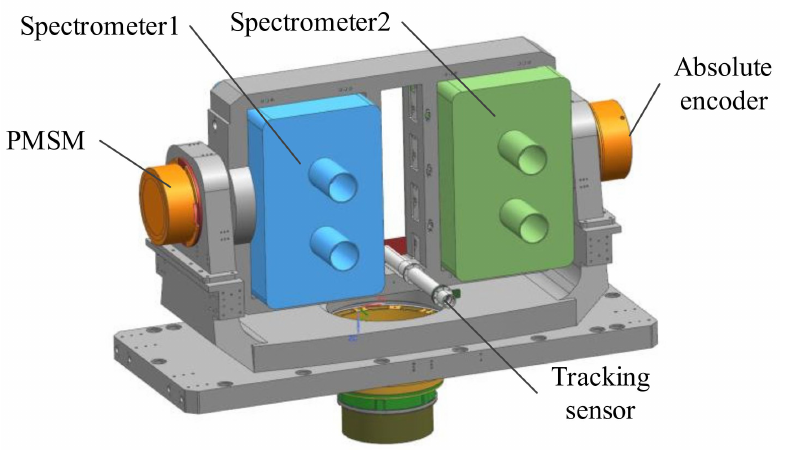
Figure 1. Schematic of the spectrometer